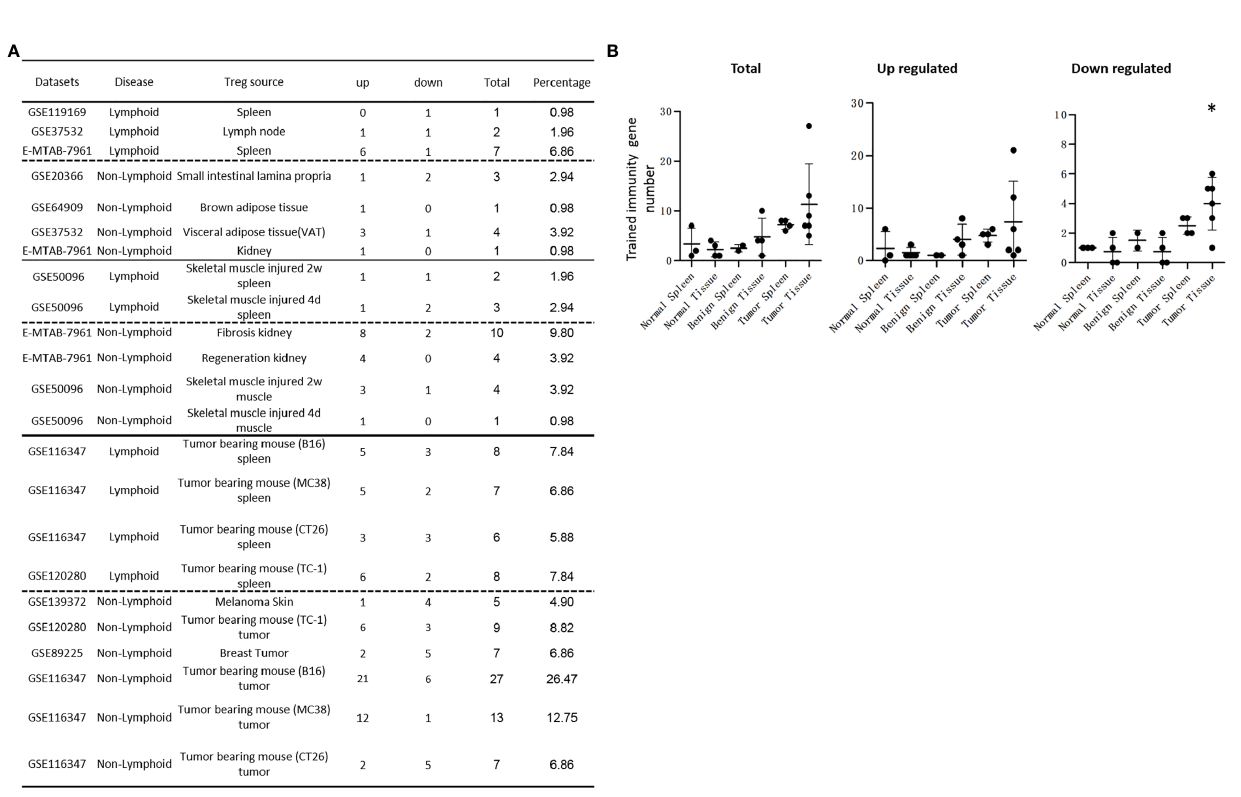
FIGURE 10 | (A) Tumor tissue Treg groups upregulated more Trained immunity enzymes than normal tissue Treg groups and benign disease tissue Treg groups. The expressions of total of 102 trained immunity enzyme genes were screened in all the Treg groups. Upregulated Trained immunity enzyme genes in tumor spleen Treg groups were more than in the normal tissue Treg groups and benign disease tissue Treg groups. However, the differences were not statistically signi fi cant. Downregulated, and total Trained immunity enzyme genes were more in tumor tissue Treg groups than in other Treg groups. (B) There were more differentially expressed trained immunity enzyme genes in tumor tissue Treg groups than other Treg groups. The total regulated trained immunity enzyme genes were more in tumor tissue Treg groups than that in normal tissue Treg group and diseased tissue Treg groups, p = 0.06. The upregulated trained immunity gene numbers had no differences between Treg groups. The downregulated trained immunity genes in tumor tissue Treg groups were more than other Treg groups, p <